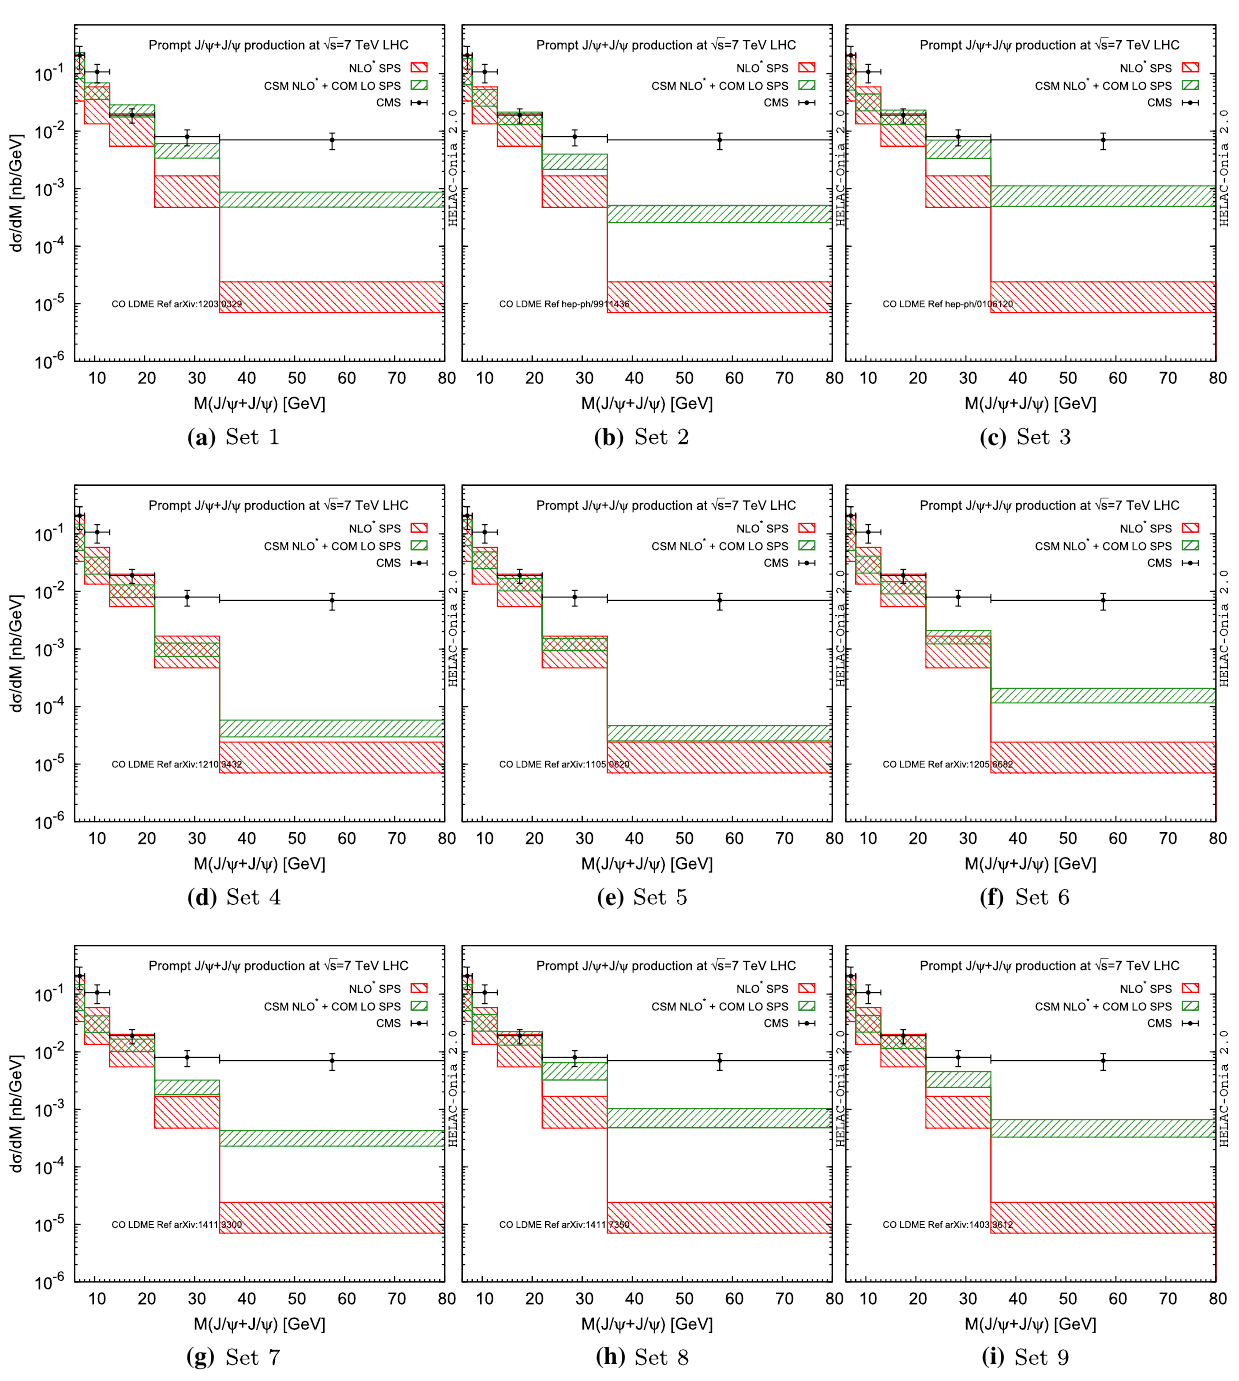
√ s = 7 TeV acceptance [21]